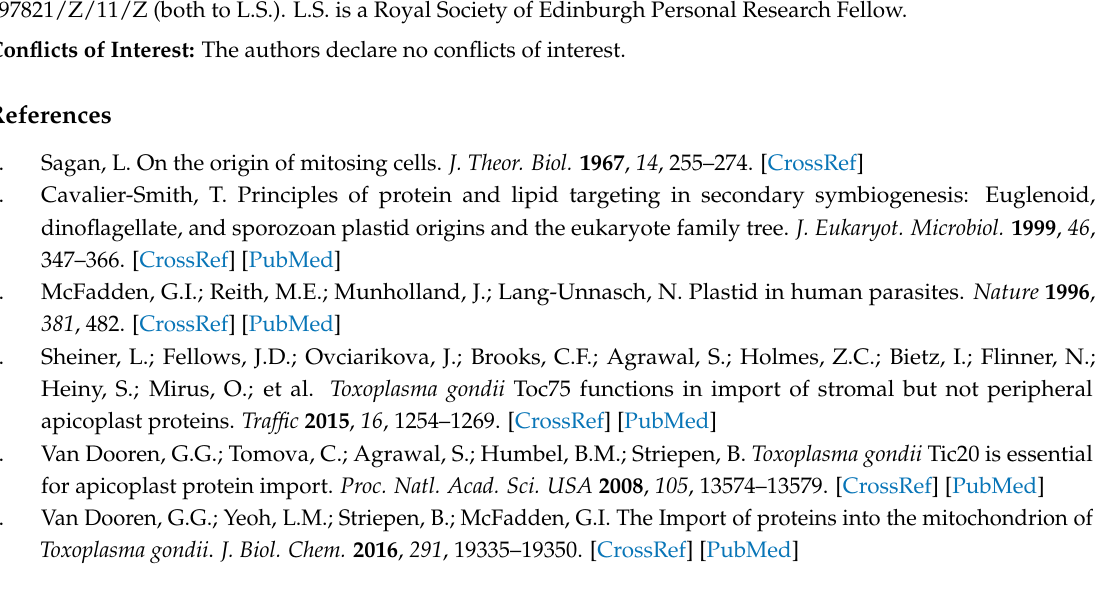
Table S1: Experimentally confirmed Toxoplasma mitochondrial proteins. The table consists of proteins for which there is experimental support for mitochondrial localization, either from microscopy of tagged proteins or from co-IP with known mitochondrial partners. * Mitochondrial sub-compartment is predicted according to the location of homologues in other studied organisms. ** Matrix location is predicted due to the method of identification (matrix proximity